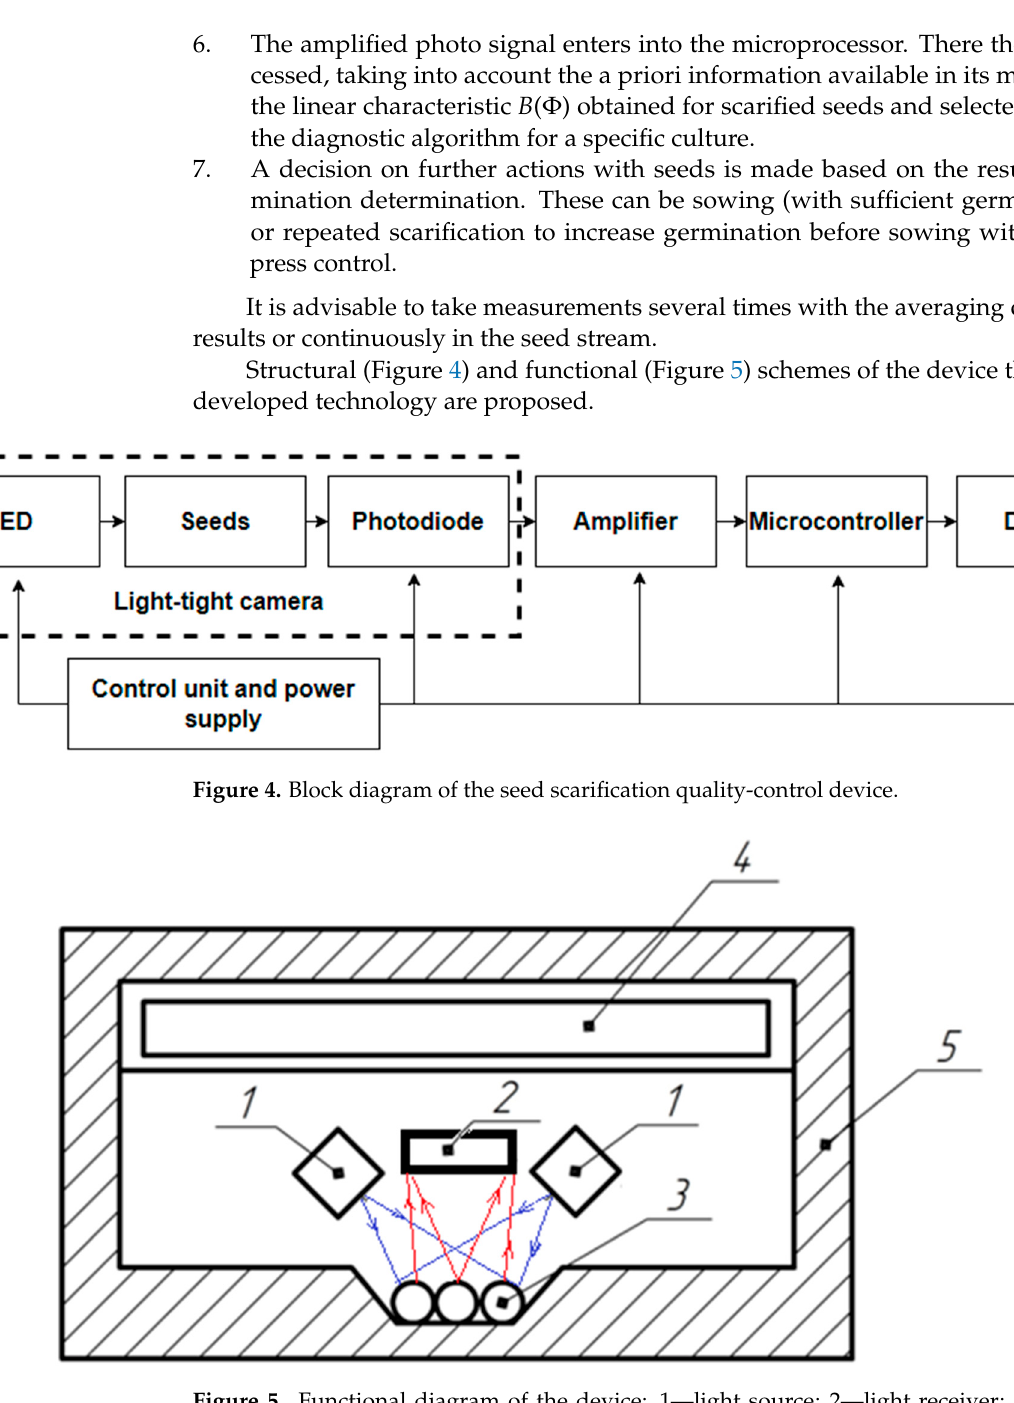
Figure 5. Functional diagram of the device: 1—light source; 2—light receiver; 3—tested seeds; 4—electronic unit; 5—light-tight housing.